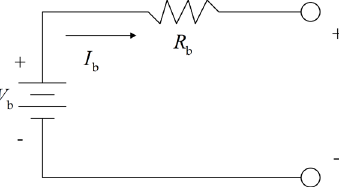
Figure 4. The Rint model of the battery.